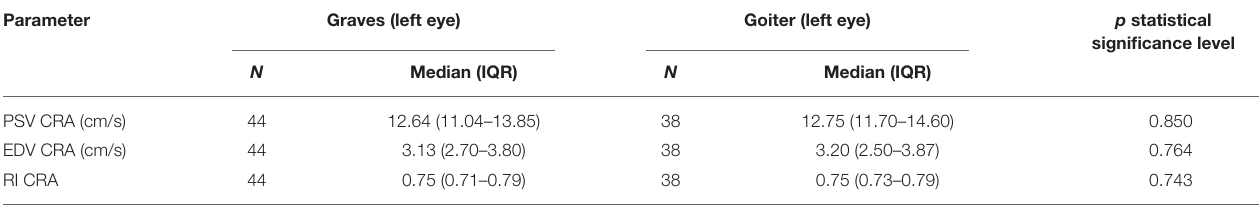
TABLE 2 | Comparison of blood flow parameters (PSV, EDV, RI) in central retinal artery in Graves’ disease and toxic nodular goiter patients.